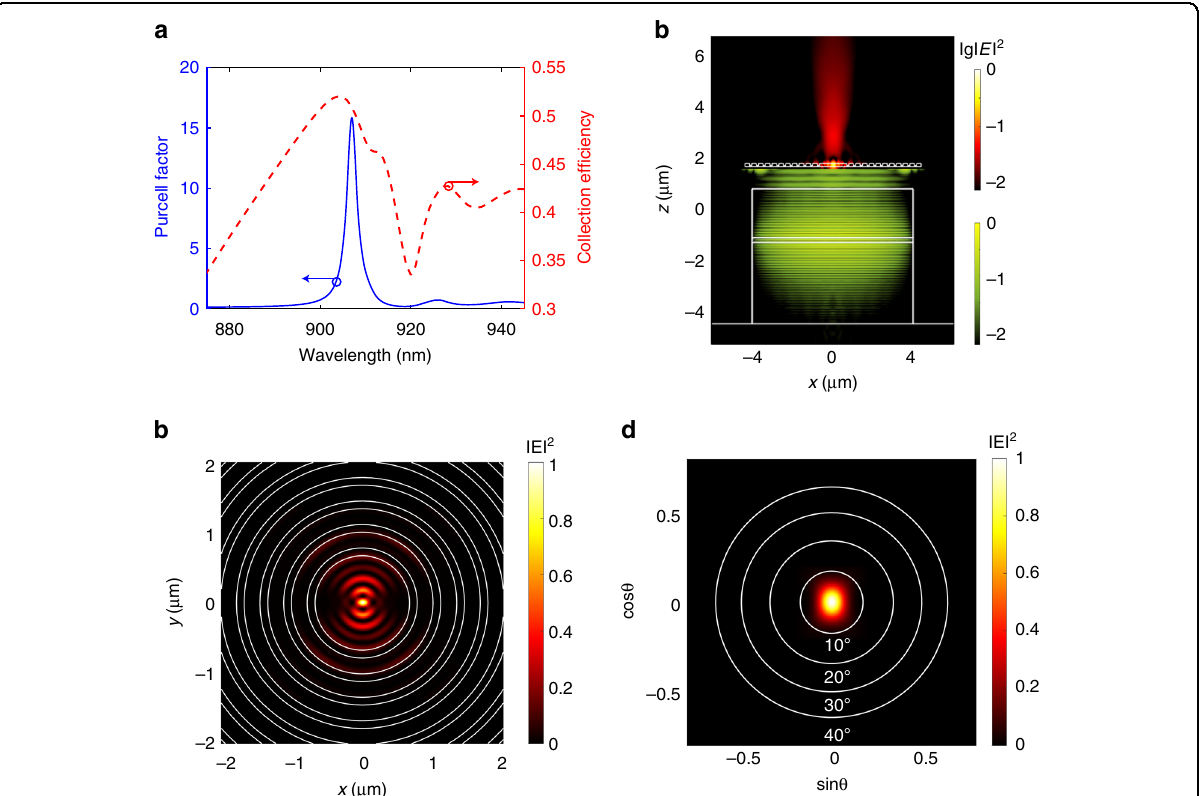
Fig. 2 Numerical simulations of the device. a Purcell factor and extraction ef fi ciency of the hybrid integrated SPS. A numerical aperture (NA) of 0.65 was used in the extraction ef fi ciency calculation. b The near- fi eld intensity distribution of the cavity mode of the CBG shows highly-localized electromagnetic fi elds. c The beam propagations of laser emissions from the micropillar and the single-photon emissions from the CBG in the XZ plane. The QD is ef fi ciently excited by the micropillar laser and emits highly-directional single photons. d The far- fi eld intensity distribution of single- photon emissions exhibits a divergent angle within